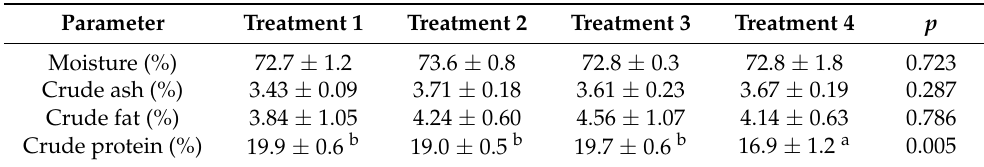
Table 4. Results of whole-body proximate composition assessment of olive flounder Paralichthys olivaceus cultured at four different initial stocking densities for 8 weeks.